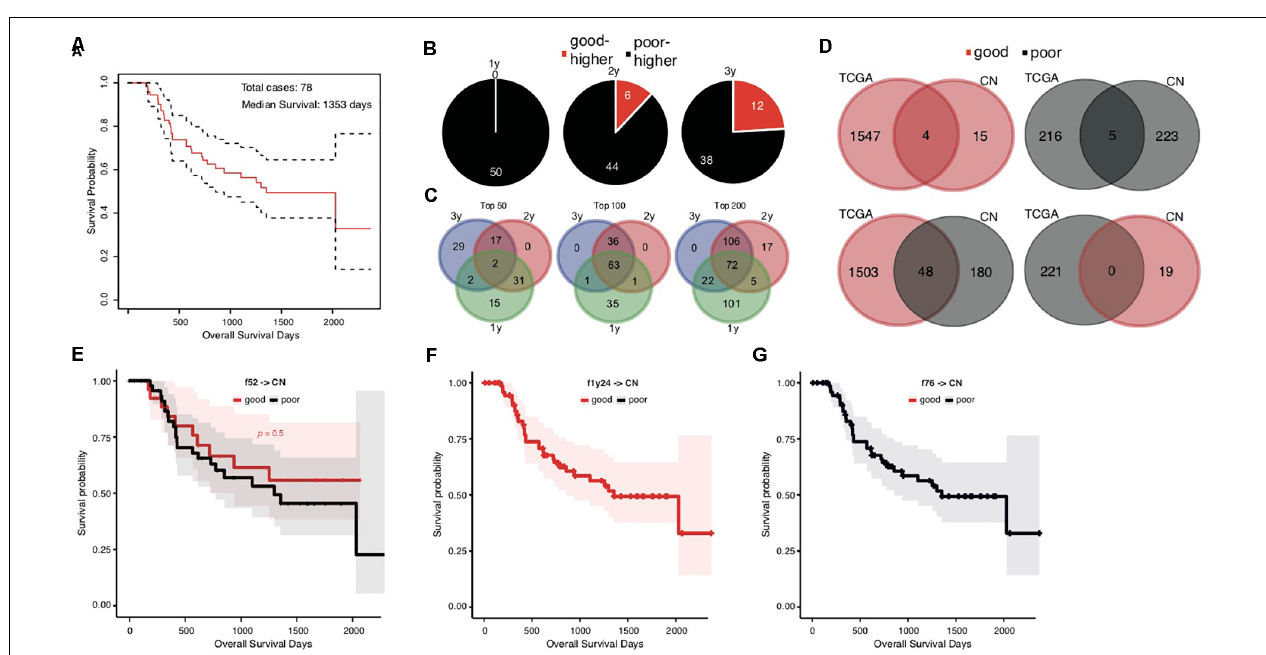
FIGURE 3 | Heterogeneity of prognosis-associated genetic signatures between TCGA and Chinese STAD cohorts. (A) The Kaplan–Meier overall survival curve of the Chinese STAD cases, with a median of 1353 days. (B) Distribution of the top 50 significant genes with different mutation rates between the good and poor prognostic groups stratified by different cutoff survival times. Genes with higher mutation rates were counted for either the good or poor prognosis group and represented as “good-higher” or “poor-higher,” respectively. The total number was also indicated. (C) The consistent intersect among the top significant genes (50, 100, or 200) identified by 1-, 2-, and 3-years stratifications. (D) The consistent intersect between the prognosis-associated gene mutation signatures of TCGA and Chinese STAD cohorts. Genes were merged for the 1-year, 2-year, and 573-day stratifications for the TCGA cohort and merged for the 1-year, 2-year, and 3-year stratifications for the Chinese cohort in the first place. (E–G) The Kaplan–Meier overall survival curves of the Chinese STAD cases classified with different models built on the TCGA training data.